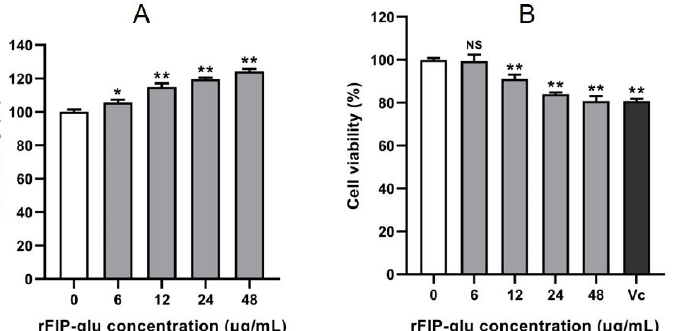
Figure 2. Safety evaluation. The e ff ects of rFIP ‐ glu on the cell viability of ( A ) HaCaT cells and ( B ) B16 cells. Vc (40 µg/mL) was used as the positive control. Data are expressed as means ± SD (n = 3). NS, p > 0.05; *, p ≤ 0.05; **, p ≤ 0.01 versus the control group.